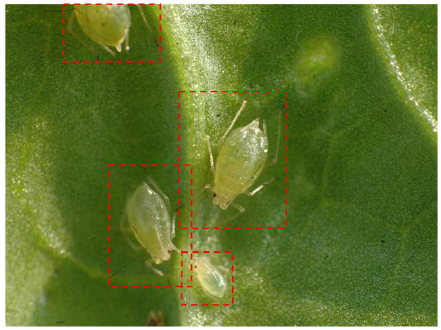
Figure 6. Pests with protective colors in the natural environment.